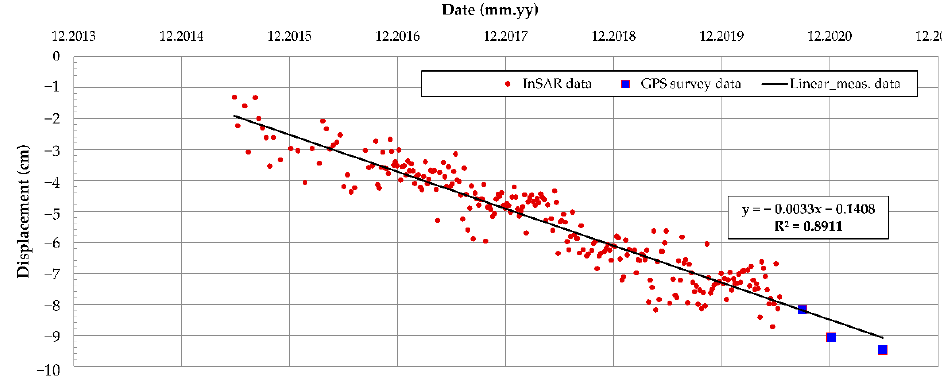
Figure 13. Oostmolendijk displacements in time obtained from InSAR [64] and GPS.